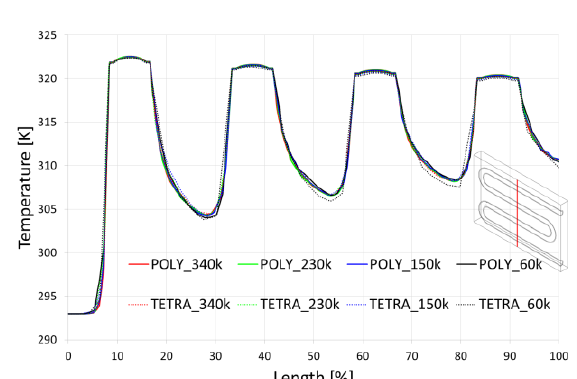
Fig. 8. Temperature distribution in the computational domain